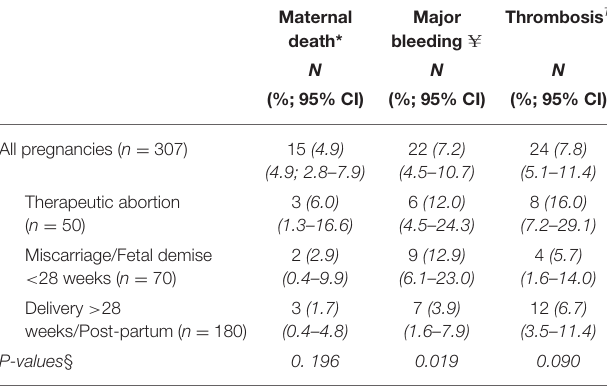
TABLE 1 | Maternal outcome in pregnant women with MHV: overall and in strata of pregnancies outcome.